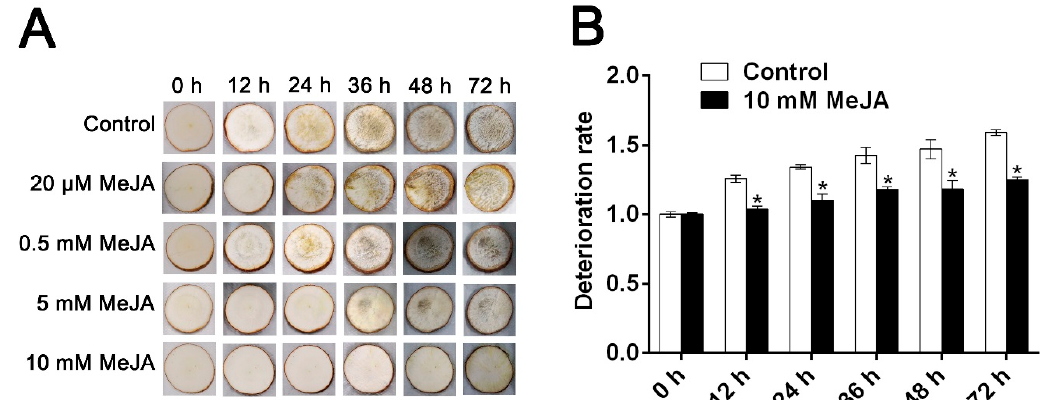
Figure 1. The effects of methyl jasmonate (MeJA) on postharvest physiological deterioration (PPD) in cassava storage root slices of South China 5 (SC5) variety. Visual detection ( A ) and deterioration rate ( B ) of storage root slices during PPD. Deterioration rate was determined by the percentages of gray values at different time points. Data are means ± SD calculated from at least three biological replicate samples. Asterisk symbols (*) indicate significant differences according to Duncan’s multiple range test at p < 0.05 at the same time points.